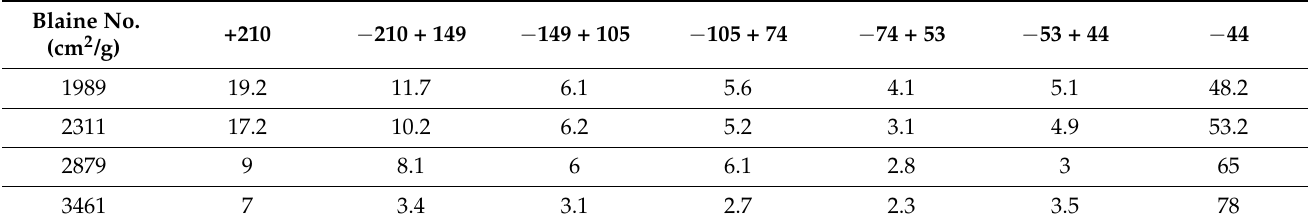
Table 2. Size fraction of (Iron Ore No.2) iron ore used size ( µ